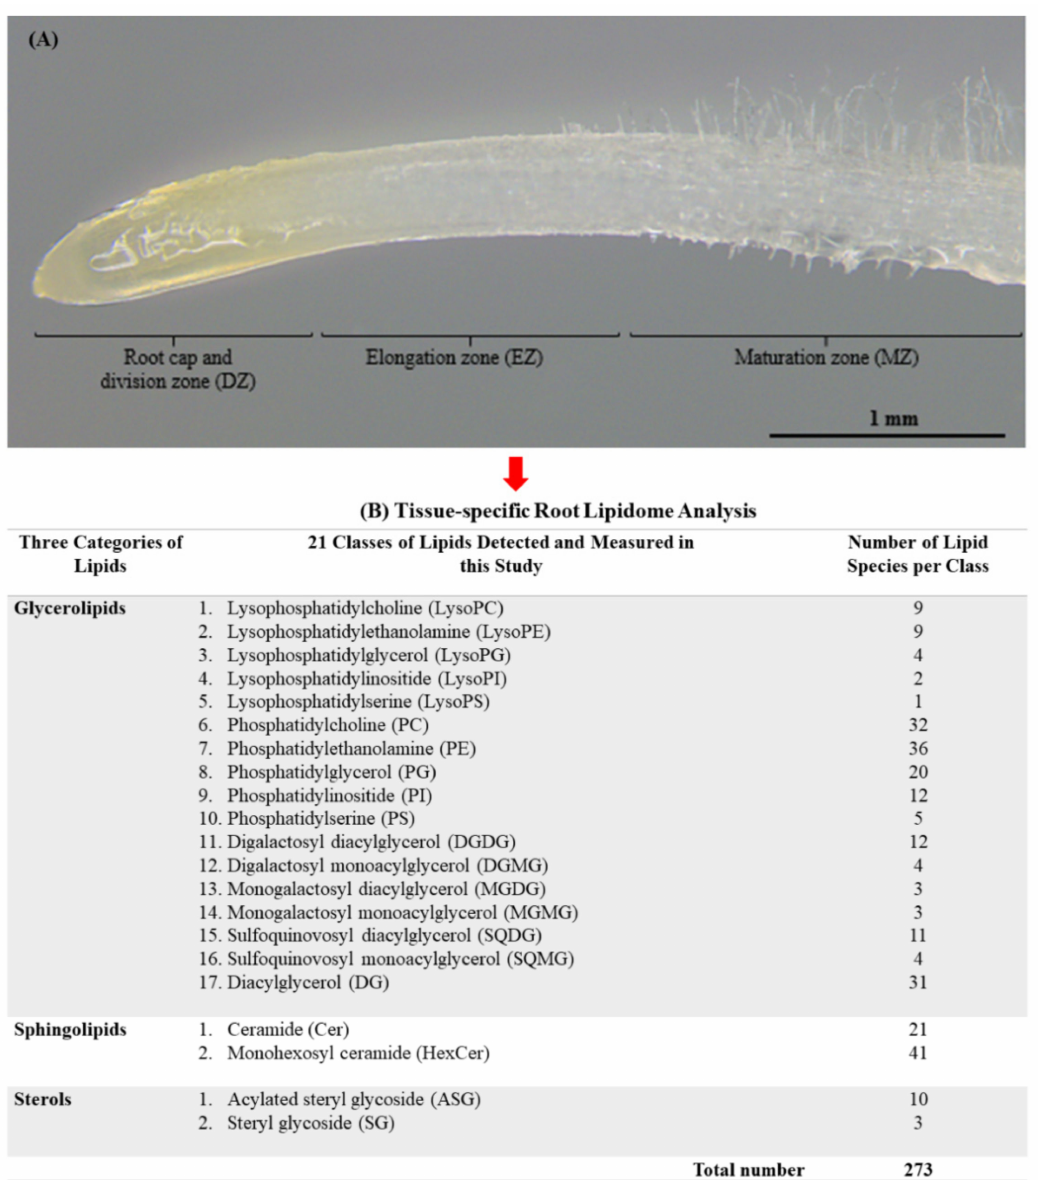
Figure 1. Tissue-specific root lipidome of Young (cold-tolerant) and Wyalkatchem (cold-sensitive) wheat varieties in this study. ( A ) The three developmental root zones of a Wyalkatchem’s young seedling. DZ = root cap and division zone, EZ = elongation zone, MZ = maturation zone. ( B ) A total of 273 lipid species derived from 21 lipid classes and three lipid categories (glycerolipids, sphingolipids and sterols) analyzed in this